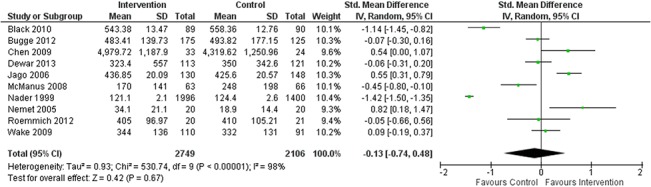
Forest Plot Showing the Standardised Mean Difference in Change in TPA between Intervention (n = 2749) and Control (n = 2106).Groups across the 10 included studies reporting TPA data.